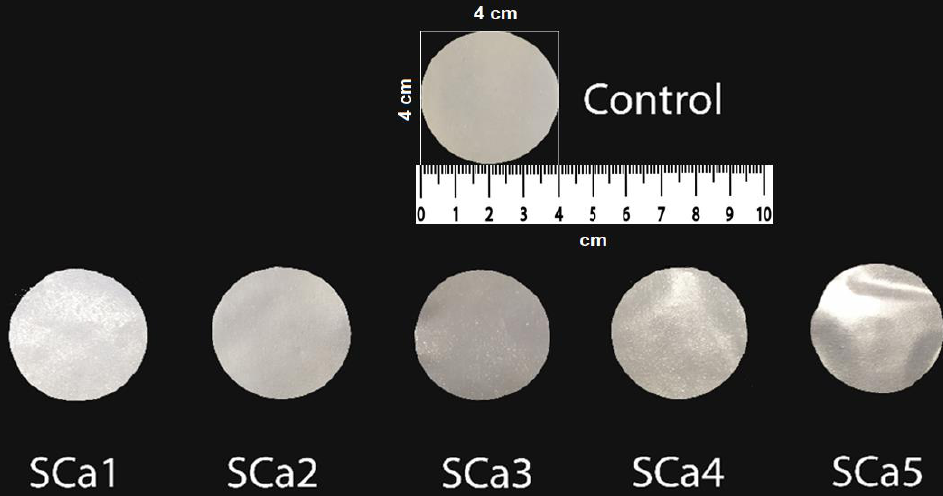
Figure 2. Variation in color between the samples with calcium chloride (SCa) addition and the control sample. SCa1-5 concentration from 0.01 to 0.1 g.